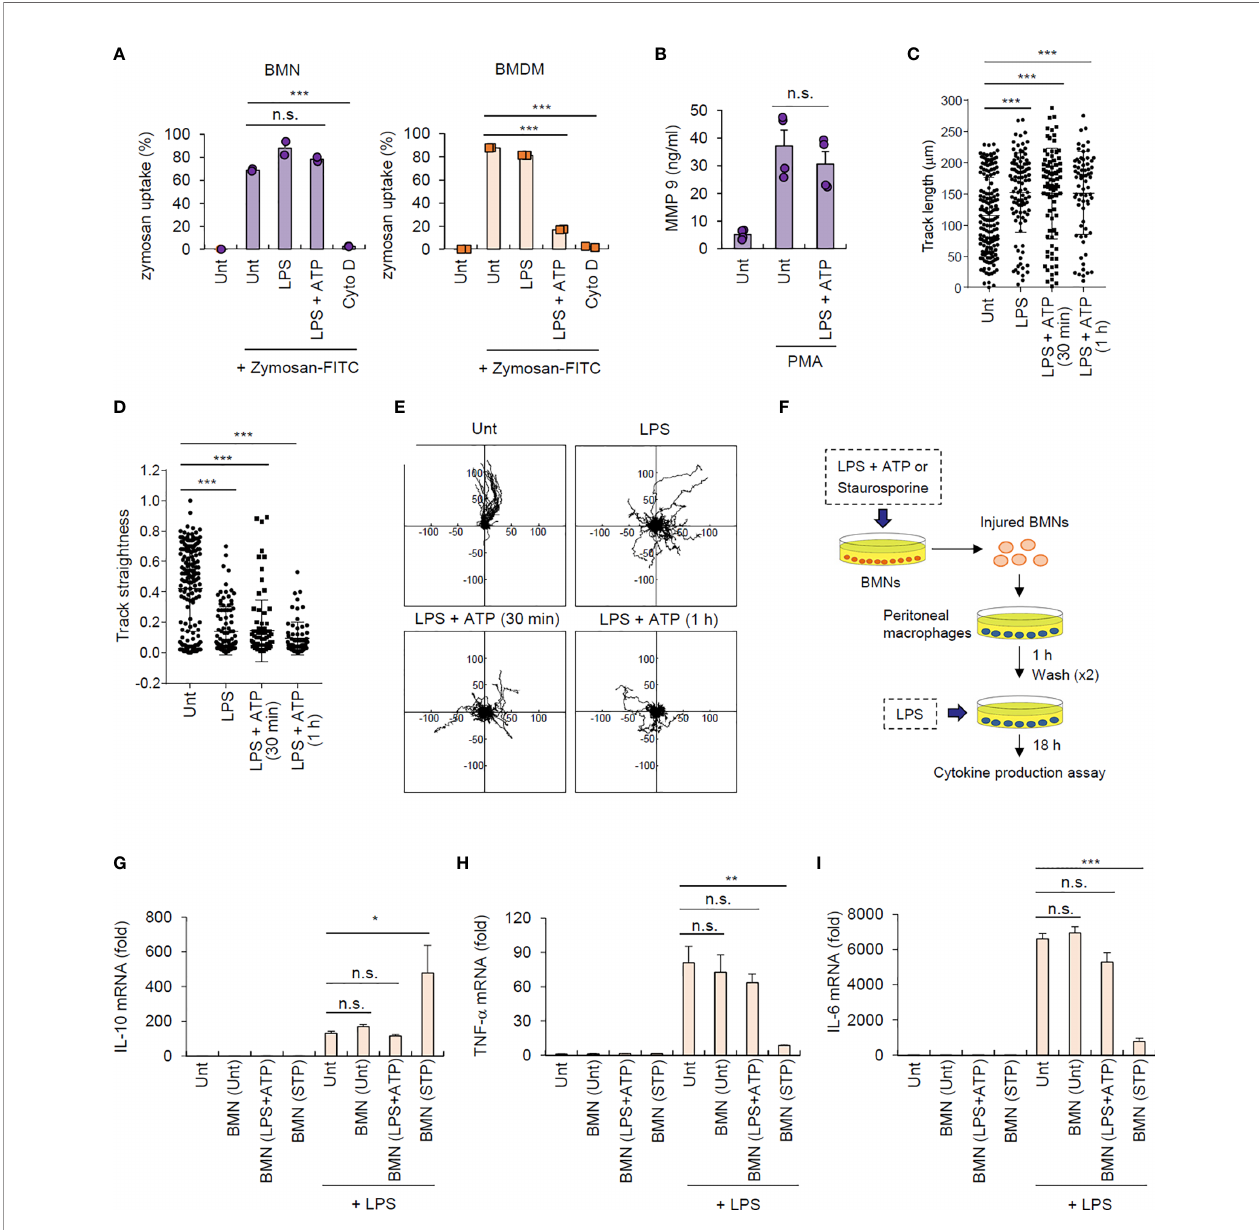
FIGURE 6 | In fl ammasome-active neutrophils maintain phagocytosis, degranulation, and migration activities, but do not trigger efferocytic anti-in fl ammatory macrophage polarization. (A) Mouse BMNs or BMDMs were untreated (Unt) or treated with LPS (0.25 m g/mL, 2.5 h) alone, LPS followed by ATP (2.5 mM, 1 h), or cytochalasin D (Cyto D, 10 m M, 30 min) as determined using fl ow cytometric analysis after incubating with zymosan-FITC (5 particles/cell, 30 min) ( n = 3). (B) Quanti fi cation of MMP-9 in the culture supernatants of mouse BMNs treated with LPS (0.25 m g/mL, 2.5 h) followed by ATP (2.5 mM, 1 h), washed and treated with PMA (1 m M, 2 h) ( n = 3). (C, D) Quanti fi cation of track length (C) and track straightness (D) of BMNs treated with LPS (0.25 m g/mL, 2.5 h) alone or followed by ATP (2.5 mM), as determined using in vitro migration assays. (E) Representative migration tracks of BMNs treated as in (C, D) . (F) Experimental scheme for determining the potential effect of in fl ammasome-active neutrophils on efferocytosis. (G – I) Mouse BMNs were untreated or treated with LPS (0.25 m g/mL, 2.5 h) followed by ATP (2.5mM, 2 h) or staurosporine (2 m g/mL, 5 h). Mouse peritoneal macrophages were treated with the injured BMNs (1:2.5 ratio, macrophages: neutrophils) for 1 h, washed and treated with LPS (0.1 m g/mL) for 18 (H) Quanti fi cation of IL-10 (G) , TNF- a (H) , or Il-6 (I) mRNA levels in mouse peritoneal macrophages treated as above ( n = 3). * P < 0.05, ** P < 0.01, *** P < 0.001, n.s. not signi fi